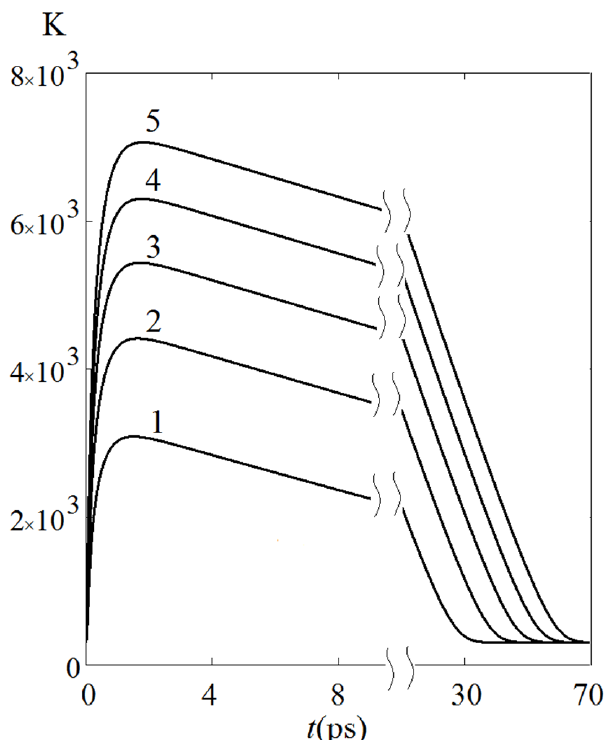
Figure 11. Kinetics of electron temperature when varying the power density of the irradiating pulse in the range PS = 50 MW/cm 2 (curve 1) − 250 MW/cm 2 (curve 5), fixed laser pulse duration tp = 100 fs, isothermal boundary condition.